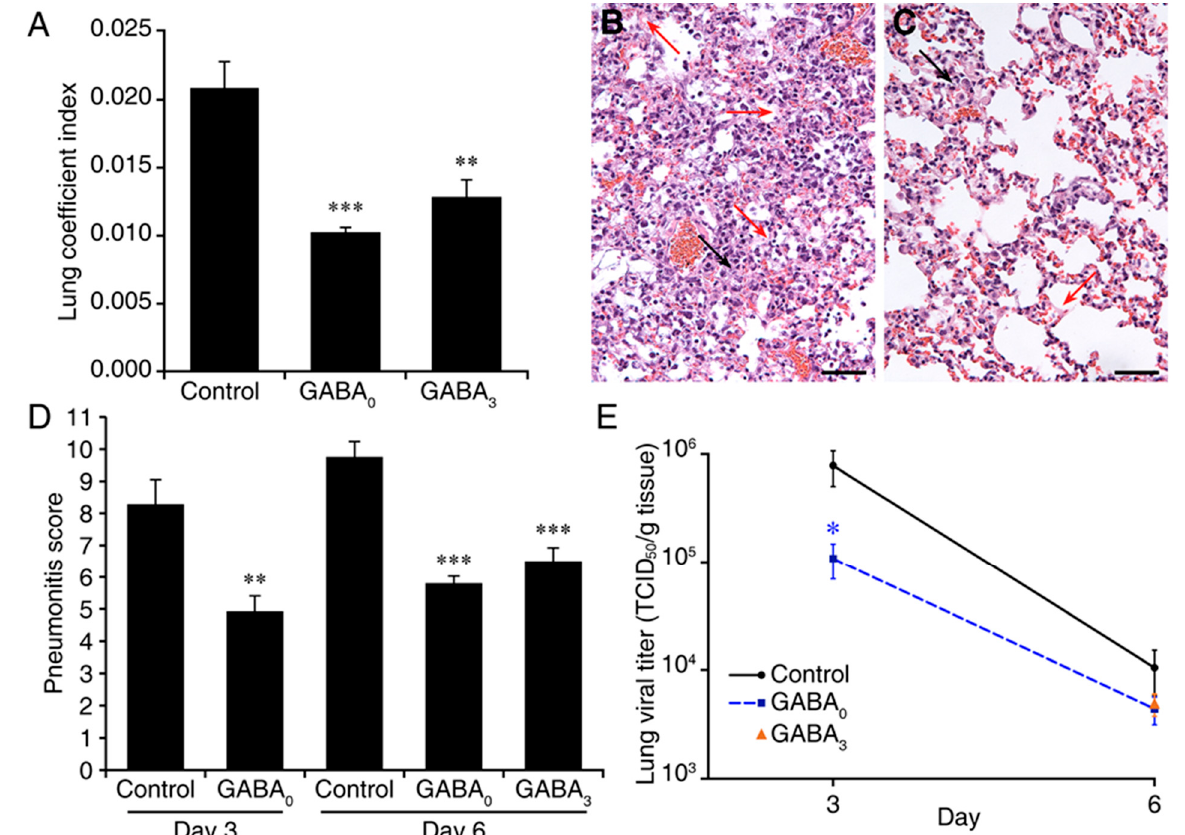
Figure 2. GABA treatment reduces pneumonitis and viral load in MHV-1-infected mice: ( A ) GABA treatment reduces lung coefficient index. Mice were inoculated with MHV-1 and placed on plain water (control) or water containing GABA (20 mg/mL) immediately (GABA0) or 3 days post-infection (GABA3). The lungs were harvested and weighed when an animal became moribund or at 14 days post-infection. Data shown are the mean lung coefficient index ± SEM for each group from two separate studies. *** p < 0.001 and ** p < 0.01 for GABA0 and GABA3 (respectively) vs. control water-treated group by Student’s t -test; ( B,C ) Histopathological features in the lungs of untreated and GABA-treated mice at 6 days post-MHV-1 infection. Representative images of H&E-stained lung sections (magnification ×200) from ( B ) untreated mice and ( C ) GABA-treated (beginning immediately following inoculation) mice. Red arrows point to hyaline-like membranes and black arrows indicate local consolidation. The scale bar is 50 µm; ( D ) Quantitative analysis of the degrees of pneumonitis in the lungs based on the number of hyaline-like membranes, % of pulmonary areas with obvious inflammatory infiltrates in lung parenchyma, and the % of area with inflammatory consolidation (as described in Materials and Methods). Data are expressed as the mean pneumonitis score ± SEM of each group ( n = 5 mice per group per time point in two independent experiments); ( E ) Kinetics of MHV-1 replication in the lungs. Mice were inoculated with MHV-1 and immediately placed on plain water (control) or water containing GABA (20 mg/mL) and 3 or 6 days later, their lungs were harvested for determination of viral load. Concurrently, another group of MHV-1-inoculated mice was given water containing GABA (20 mg/mL) beginning 3 days post-infection, and the viral load in their lungs was determined 6 days post-infection. The data shown are the mean TCID50/g of lung tissue ± SEM at the indicated days. GABA0 mice (blue square symbol) received GABA immediately after inoculation and GABA3 mice (orange triangle symbol) received GABA beginning 3 days post-infection. n = 5 mice per group at each time point. * p < 0.05 by Student’s t -test.